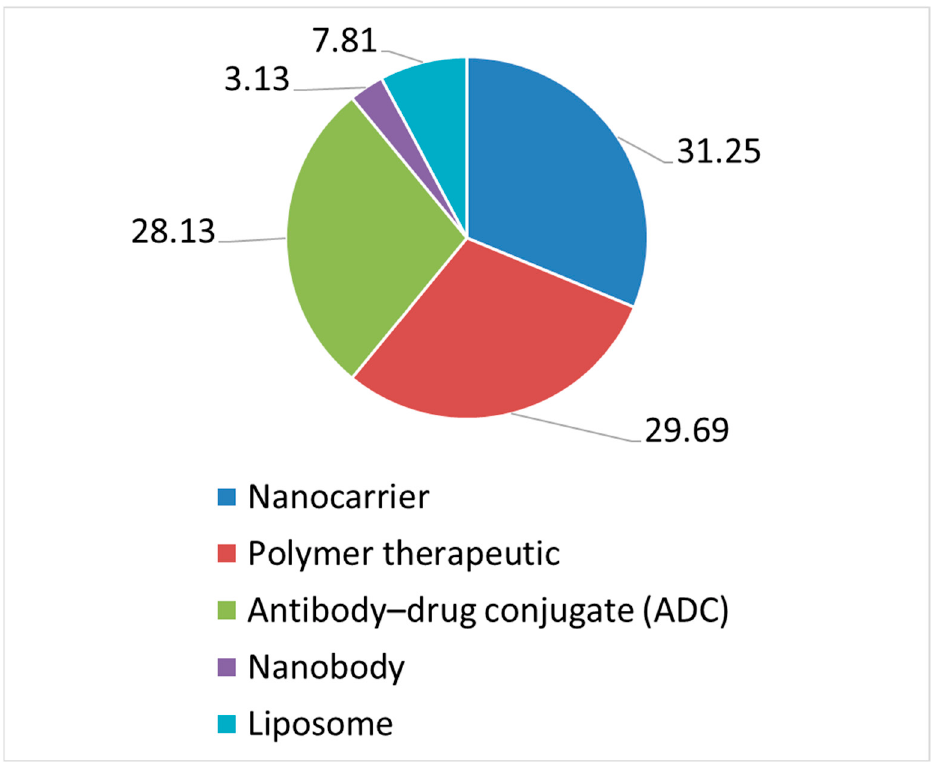
Figure 3. Categories attributable to nanomedicines identified in CTs assessed and authorized from 2018 to 2020.